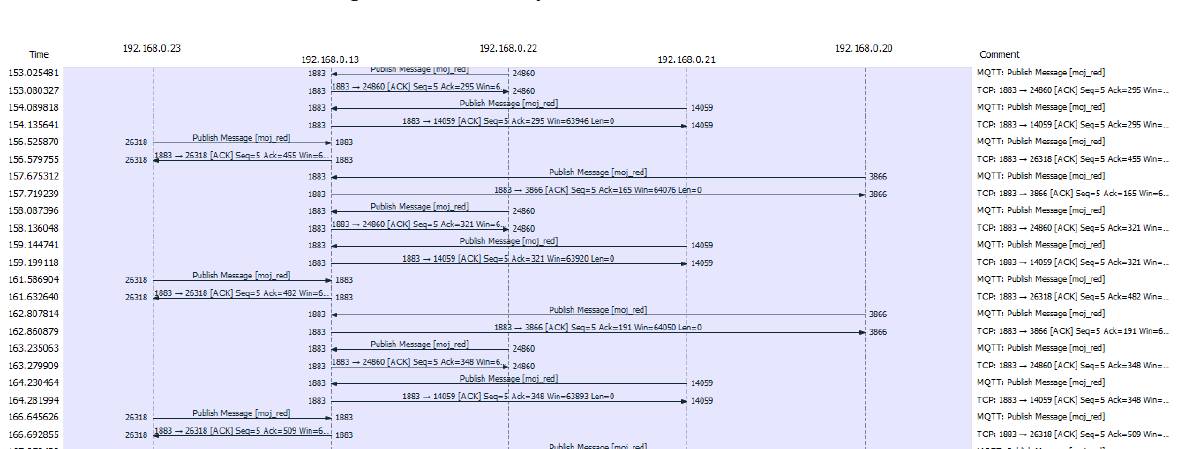
Figure 12. Communication flow between the server and the four sensor nodes with error packets. As said before, the system traffic data were collected during the experiment using Wireshark, a network analyzing tool. The traffic was saved in the pcapng, and latter ex- ported to CSV file and further analyzed with the Python script for creating the traffic sta- tistics and analyses. The traffic statistics are given in Table 3. It is evident that the number of errors, or more accurately the number of packet retransmissions, was very low during all four sce- narios. It ranged from 0.00 to 0.81 percent. It is also obvious that the increase of the packet load did not affect the increase in the packet transmission errors, or TCP packet retrans- missions. Table 3. Packet load and statistics per packet type for four different scenarios. Packet Type